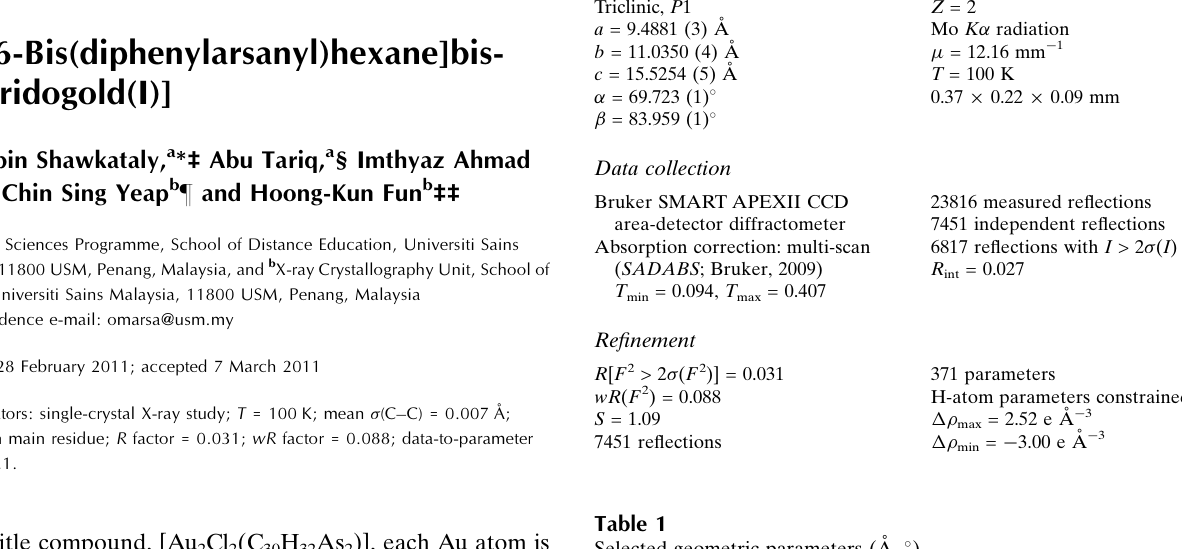
Selected geometric parameters (A˚ , (cid:3) ).